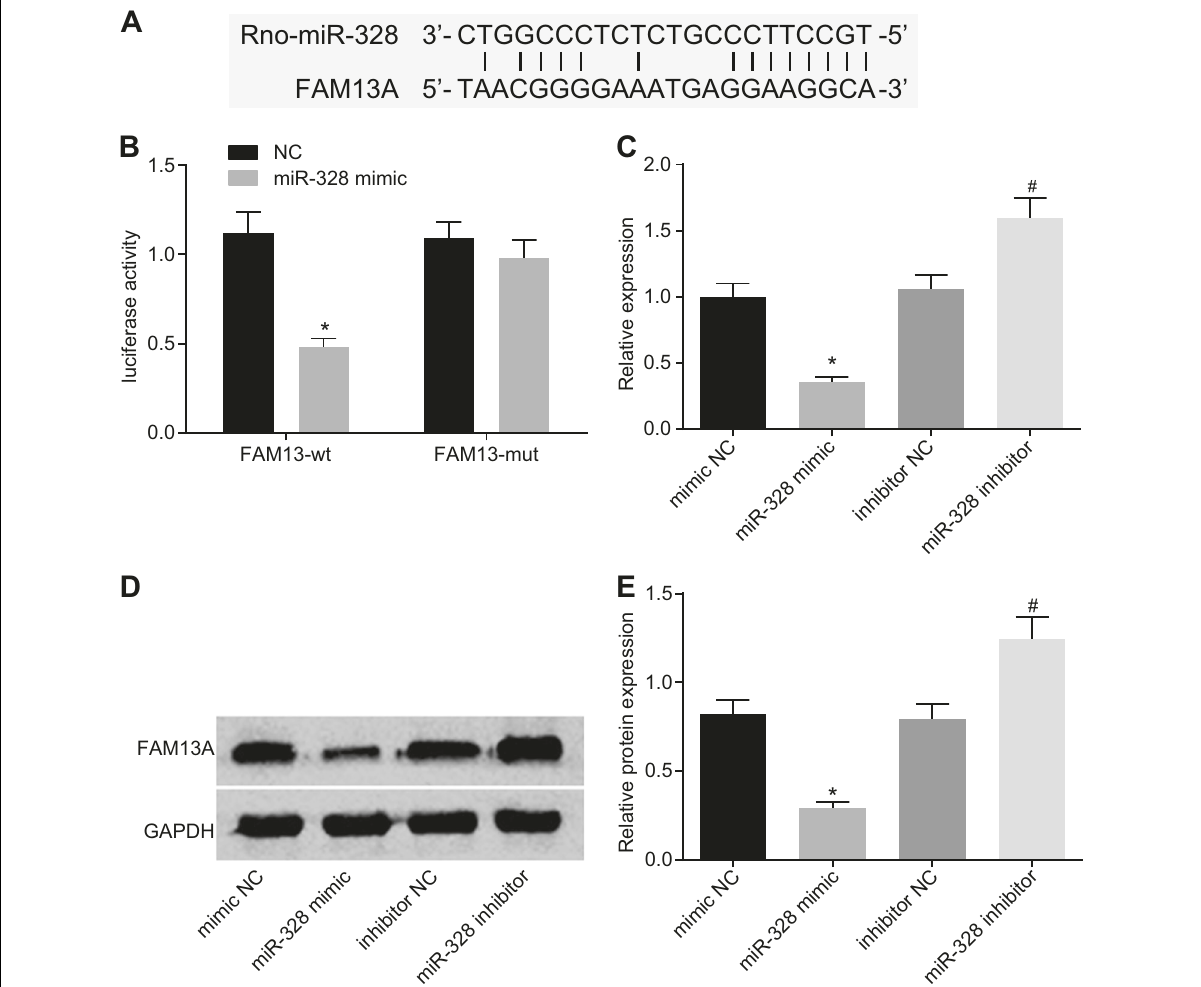
Fig. 3 miR-328 negatively targets FAM13A . a The potential binding sites for the interaction between miR-328 and FAM13A. b The luciferase activity of FAM13A-WT and FAM13A-MUT with or without the cotransfection of miR-328. * p < 0.05 vs . the NC group. c The mRNA level of FAM13A after altering miR-328 activity. d , e The protein level of FAM13A after altering miR-328 expression. * p < 0.05 vs . the mimic NC group; # p < 0.05 vs . the inhibitor NC group. miR-328, microRNA-328; FAM13A, family with sequence similarity 13, member A; RT-qPCR , reverse transcription quantitative polymerase chain reaction; NC, negative control; WT, wild type; and MUT, mutant type. The results were measurement data and are expressed as the mean ± standard deviation. The data in Fig. 3b were analyzed using an unpaired t -test, and the data in Fig. 3c and e were analyzed using one-way analysis of variance; the experiment was conducted in